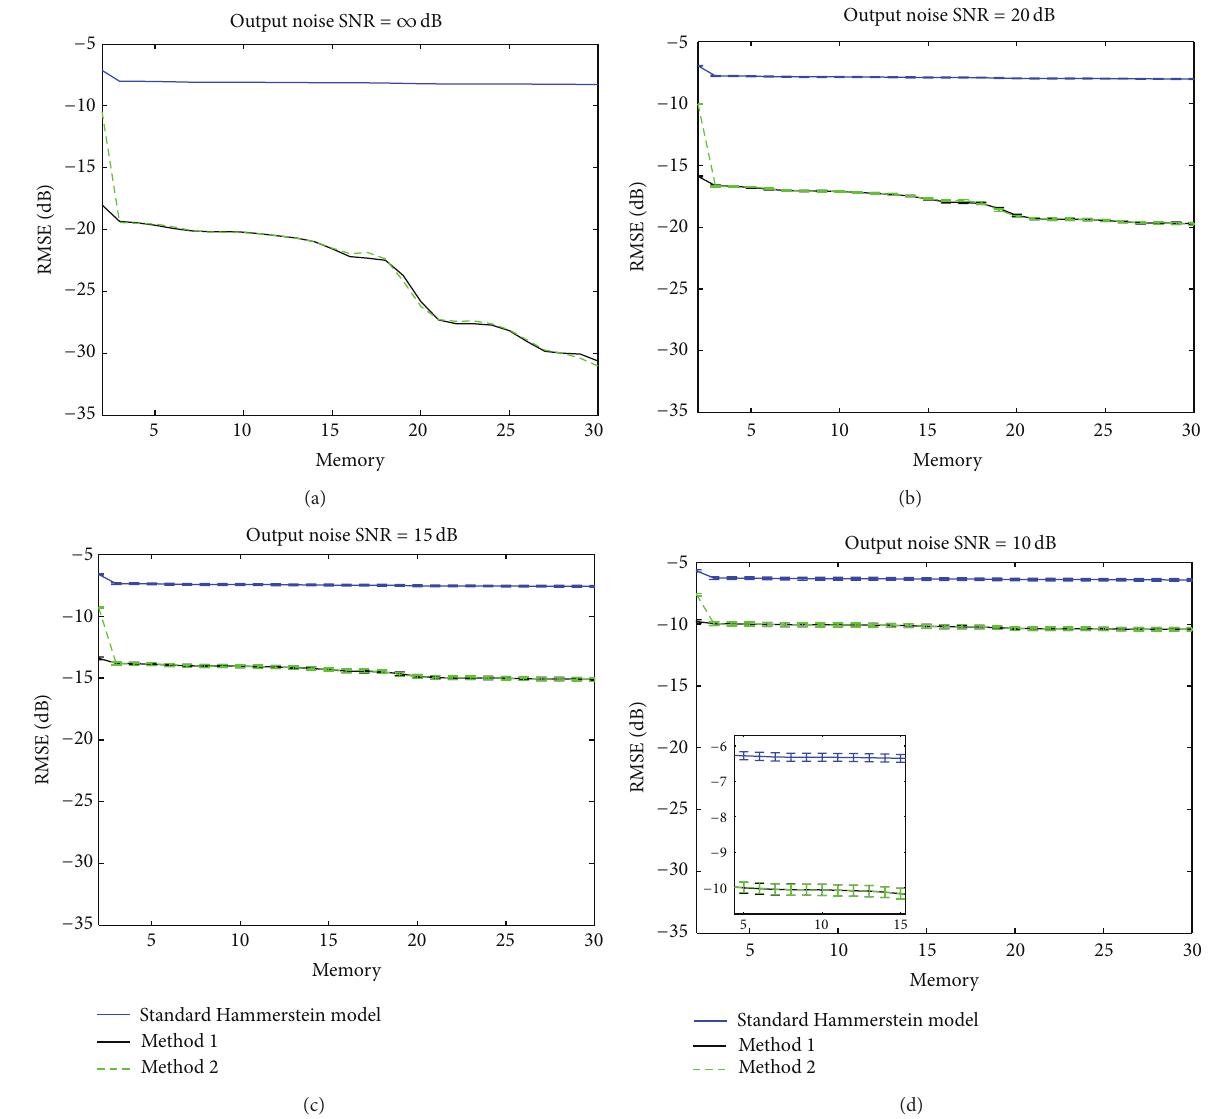
Figure 8: Variation of RMSE in dB between the backscattered signal by the contrast agent and that modeled with (blue) the standard Hammerstein model, (black) method 1, and (green) method 2 as a function of the memory of Hammerstein model in presence of output noise: SNR = ∞ dB, SNR = 20 dB, SNR = 15 dB, and SNR = 10 dB.